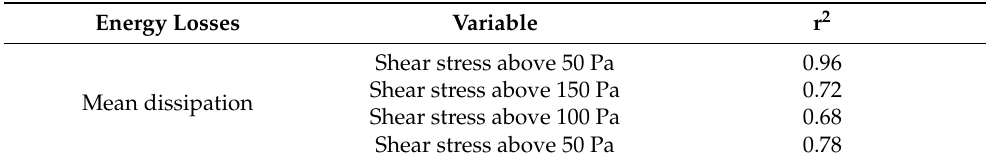
Table 3. Spearman’s rank correlation analysis of mean energy losses and non-physiological shear stress